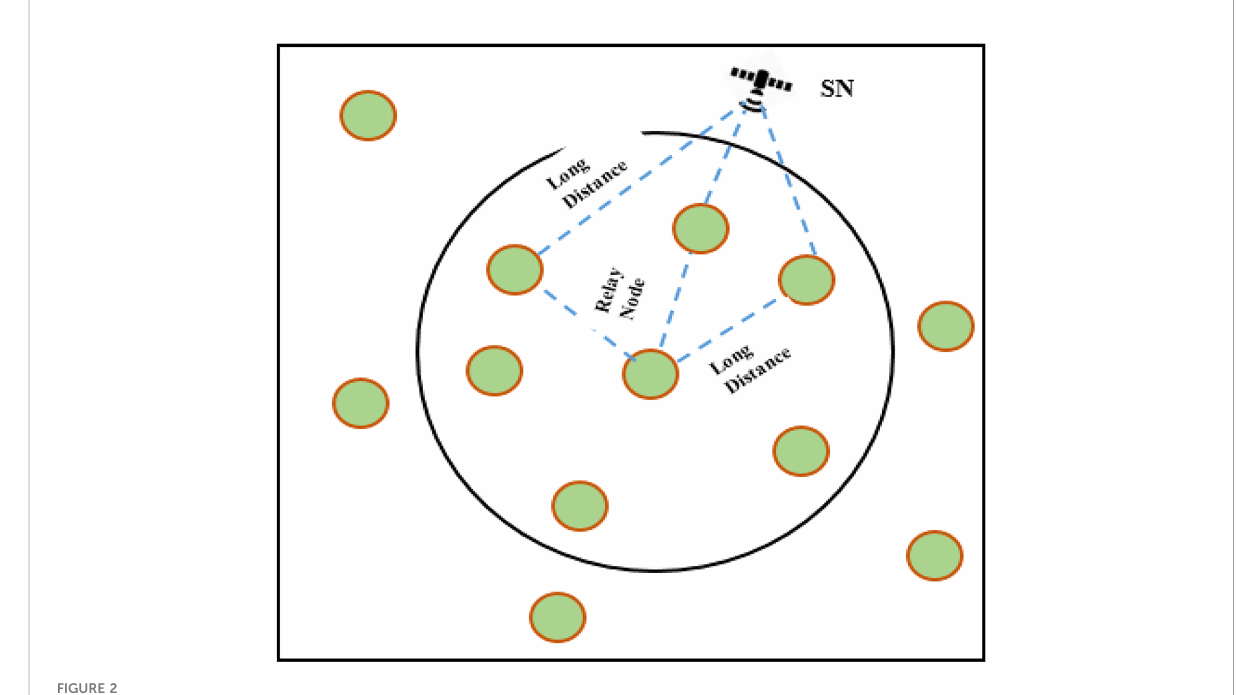
FIGURE 2 Packet transmission trough Relay node.